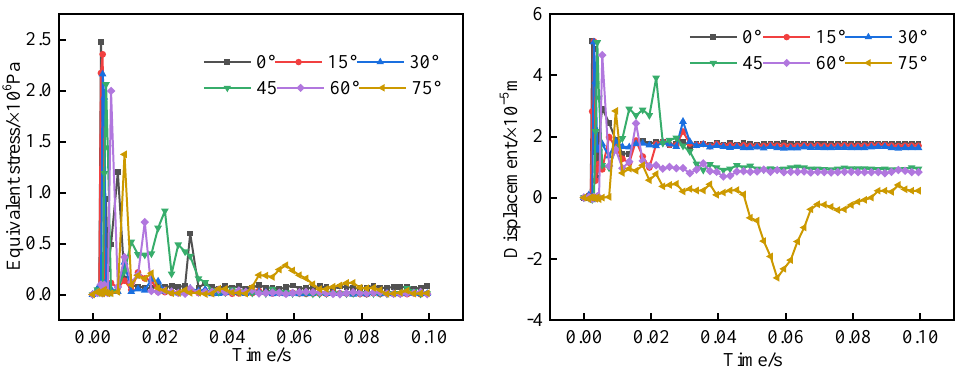
Figure 11. Time – history curves of equivalent stresses ( left ) and X -displacements ( right ) for different collision angles.